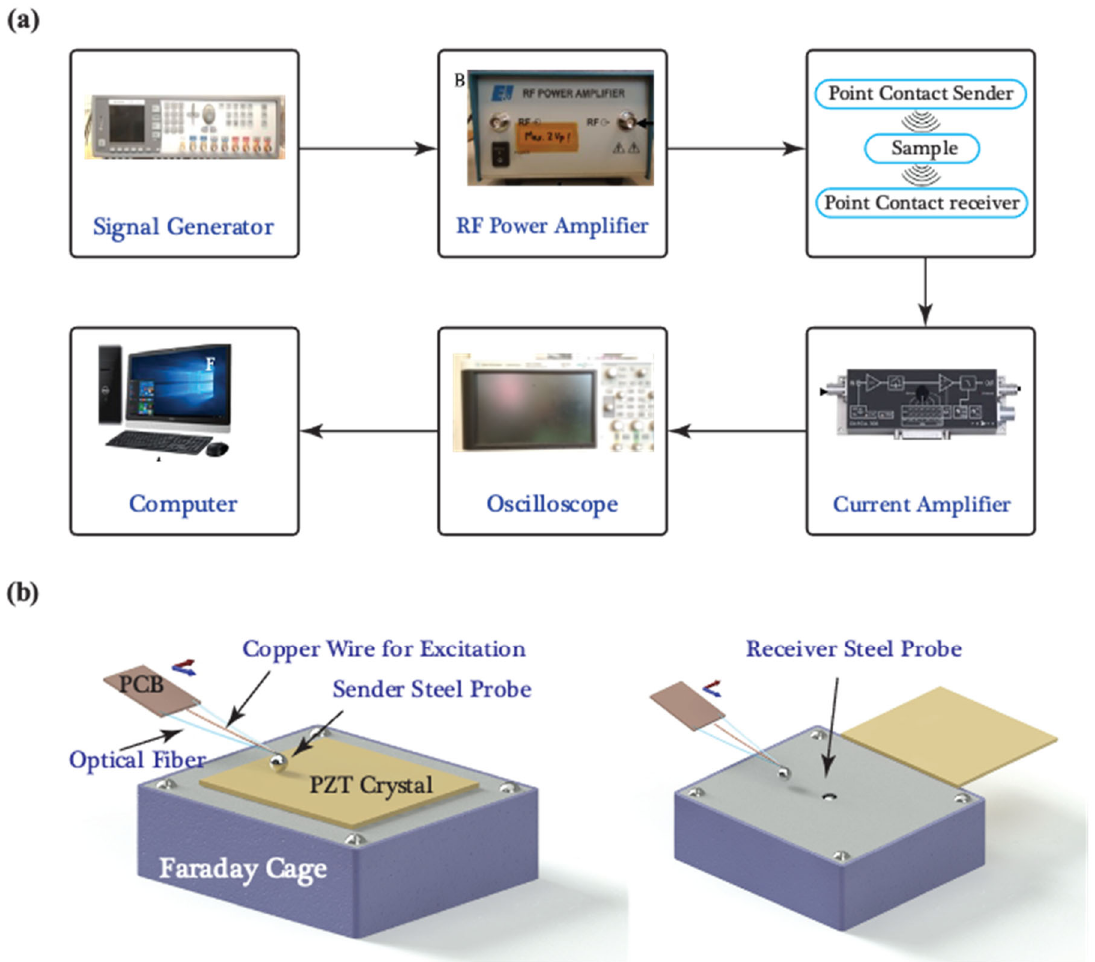
Figure 1. ( a ) Experimental setup for point contact excitation and detection scheme and ( b ) 3D illustration of the arrangement of sender and receiver steel probe along with the PZT sample.